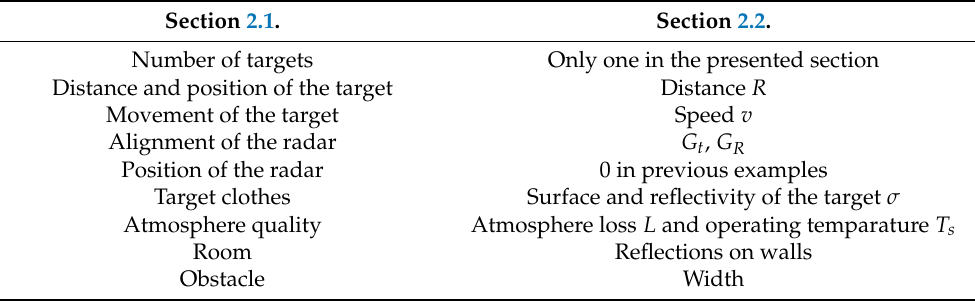
Table 2. Equivalences between physical quantities. Section 2.1. Section 2.2. Number of targets Only one in the presented section Distance and position of the target Distance R Movement of the target Speed v Alignment of the radar G t , G R Position of the radar 0 in previous examples Target clothes Surface and reflectivity of the target σ Atmosphere quality Atmosphere loss L and operating temparature T s Room Reflections on walls Obstacle